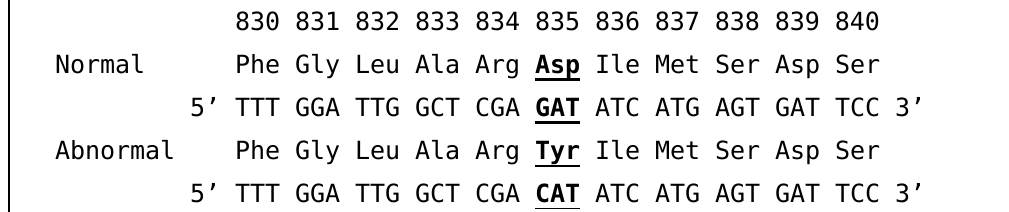
FAB: French-American-British. ITD: Internal Tandem